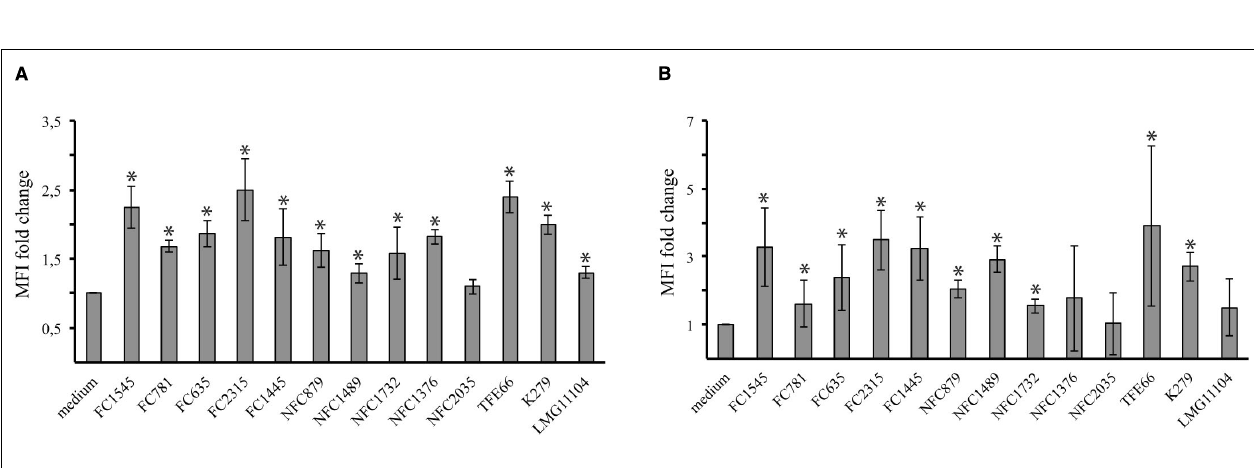
FIGURE 3 | Stenotrophomonas maltophilia strains induce dendritic cells maturation. Bar graphs shown the fold change in CD80 (A) and CD86 (B) expression after 18 h of incubation. CD86 and CD80 expression on DCs was measured by flow cytometry.